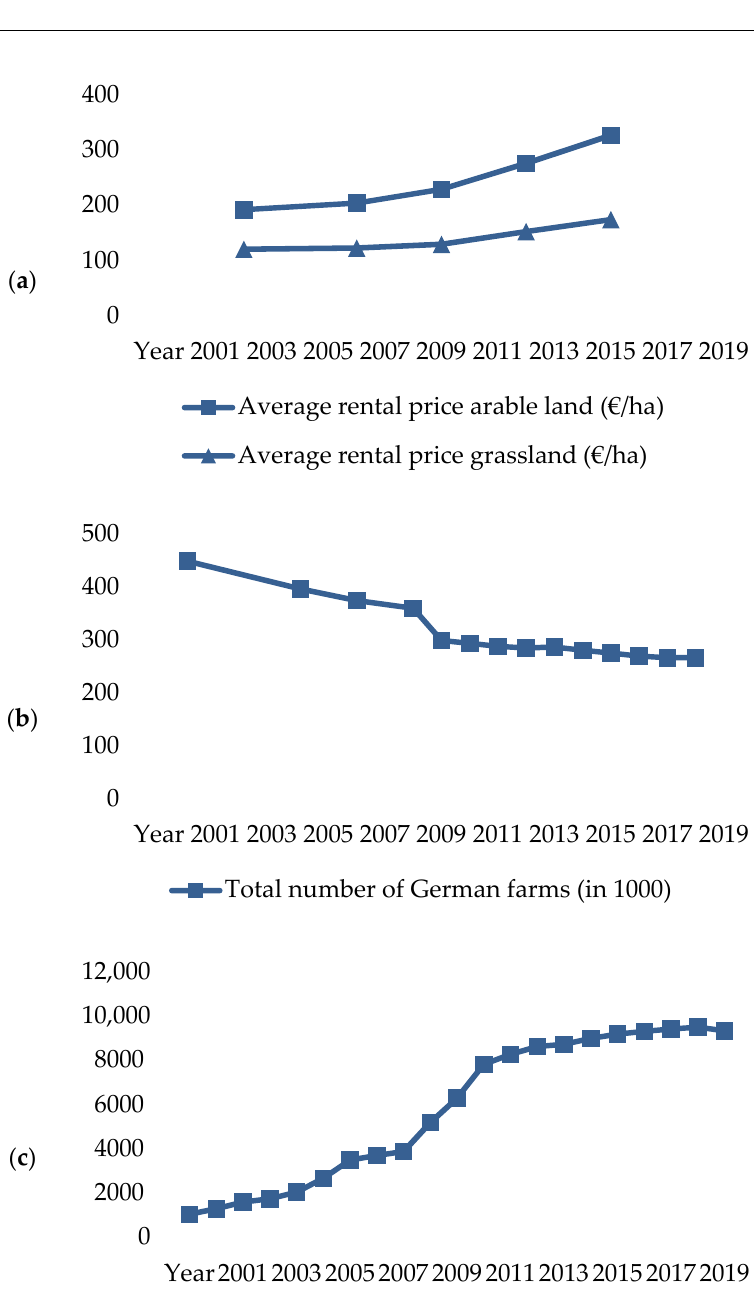
Figure 2. Development of ( a ) the average rental prices for arable land and grassland, ( b ) total number of German farms, and ( c ) total number of biogas plants (2000–2020). Source: German Farmers Association [10] and Federal Statistical Office of Germany [59,60].